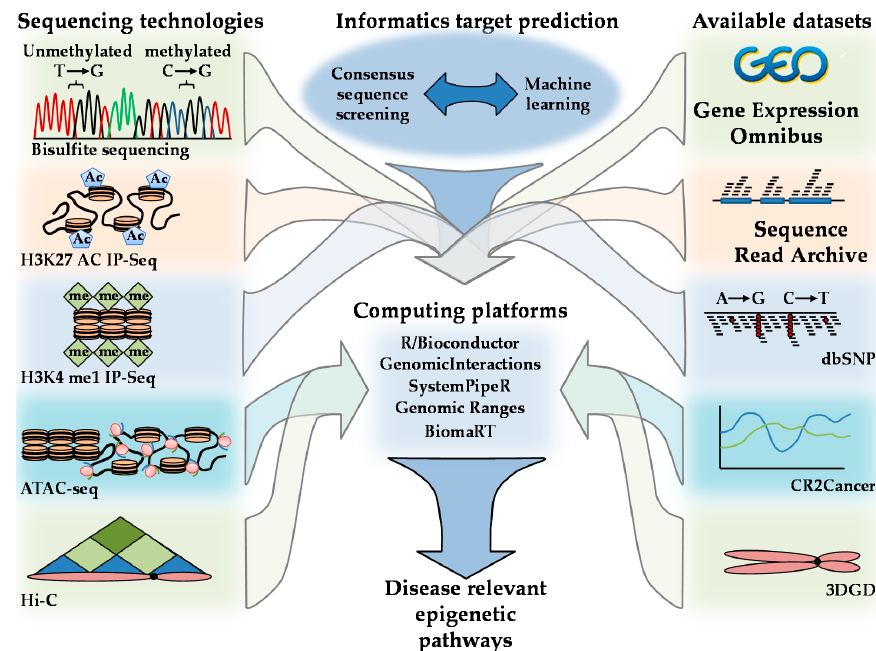
Figure 7. Methods for resolving disease-relevant AMPK-regulated epigenetic networks. Developed sequencing technologies are listed on the left-hand figure panels. Publicly available data repositories are listed on the right. Computing platforms R and relevant Bioconductor packages including Genomic interactions, SystemPipeR, Genomic Ranges, and BioMart can be used to integrate sequencing technologies, publicly available datasets, and AMPK target predictions as illustrated in the center